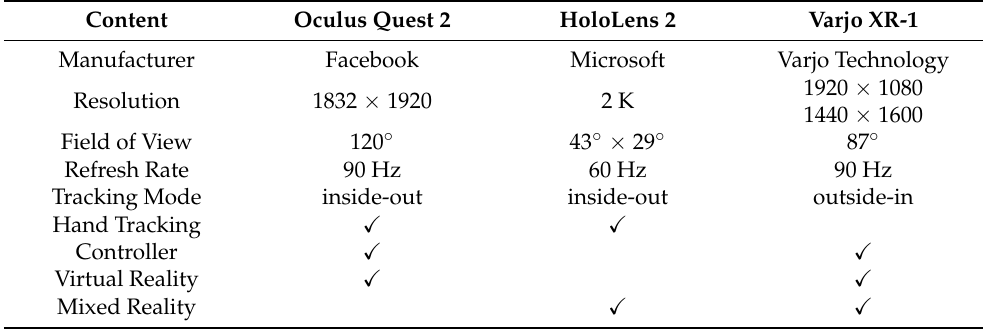
Table 2. XR devices comparison: the basic design parameters and features of three XR devices used in the service layer, namely Oculus Quest 2, HoloLens 2, and Varjo XR-1. Content Oculus Quest